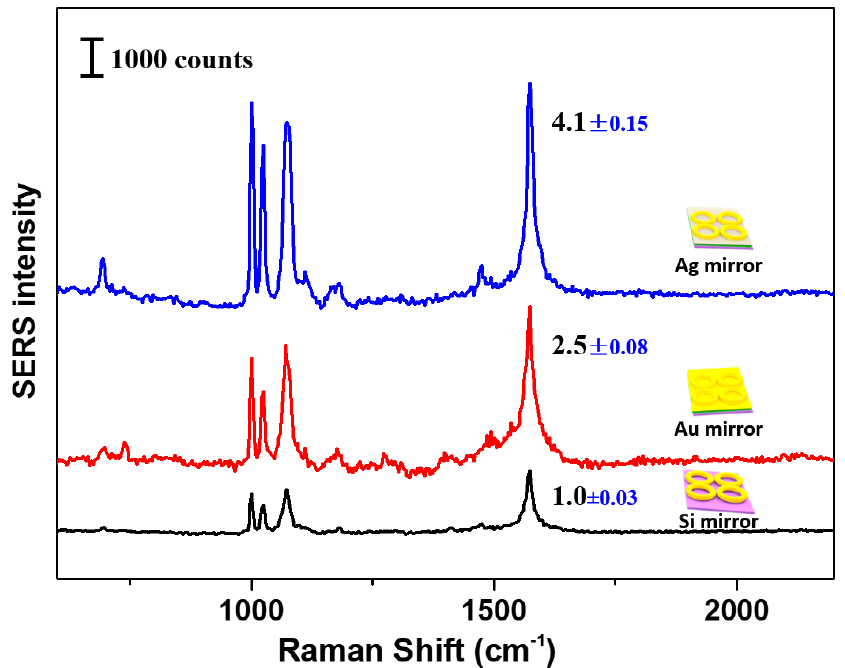
Figure 2. SERS intensities of benzenethiol molecules at monolayered Au nanorings deposited on Si (black trace), Au (red trace), and Ag (blue trace) mirrored substrates. Nanomaterials 2020 , 10 , x FOR PEER REVIEW